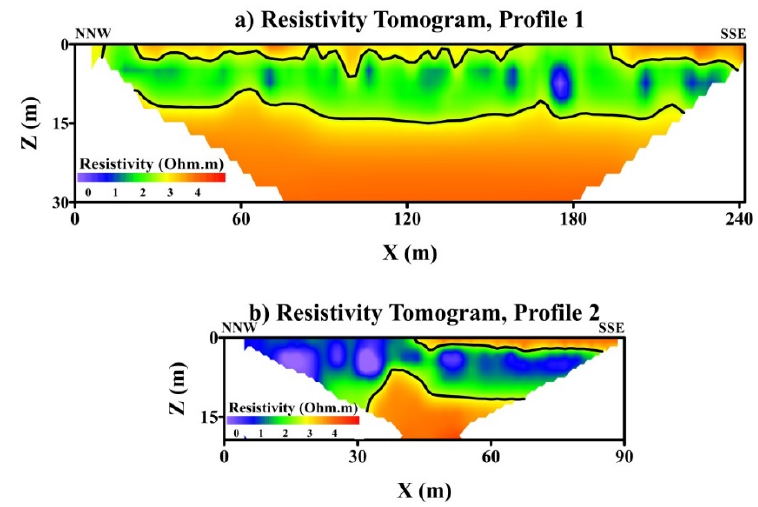
Figure 14. Resistivity profiles running from the channel edge on the left toward the middle of the channel.